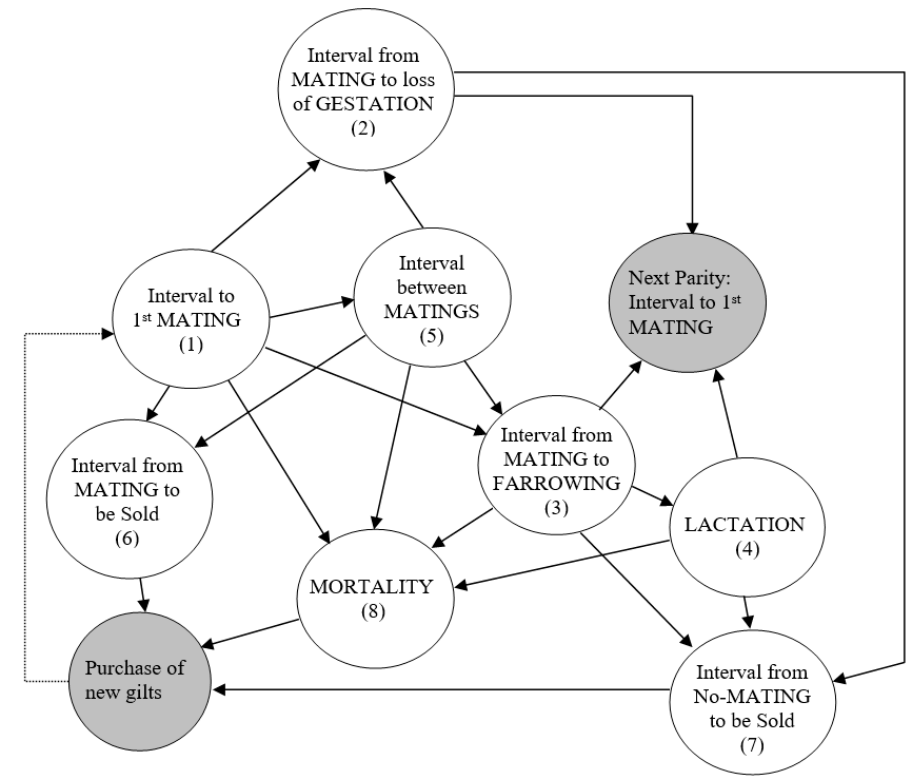
Figure 1. Digraph representing the (first) reproductive cycle of a sow: the states (the eight num- bered nodes) and transitions allowed are represented by arrows. Note that there is an entry state representing the purchase of gilts and a link to the next reproductive cycle state (gray color). Table 1. Time interval distributions, in days, obtained from data in the included a farm from March 2016 to March 2019. Distributions were obtained by splitting the observation period into an endemic period (En) (from March 2016 to May 2018) and endemic and epidemic period (En/Ep) (from March 2016 to March 2019). N (x,y) means a normal distribution, where x and y are the mean (in bold) and standard deviation of the distribution, respectively. log N (x,y) means a log normal distribution, where x and y are the mean and standard deviation of the distribution,